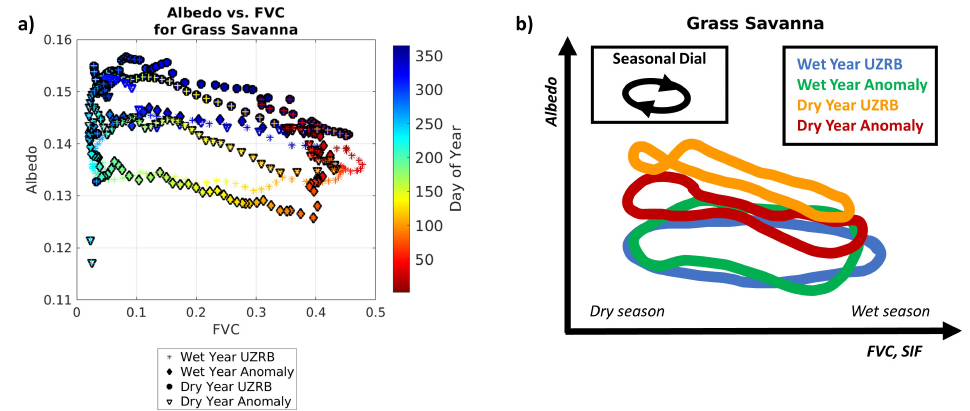
Figure 18. ( a ) Phase-space analysis of mean albedo and FVC values for grass savanna pixels for a wet year (2010–2011) and a dry year (2015–2016) across the entire UZRB, as well as for the midland wetland area that receives localized precipitation (Anomaly) [52]. The 95% confidence interval values were plotted as horizontal and vertical error bars, with bar lengths representing the distance of the interval endpoints to the mean. ( b ) On the right is a conceptual diagram that synthesizes the impact of afternoon convection (Anomaly) produced by local circulations organized by land–atmosphere interactions and groundwater convergence [52] on the seasonal cycle of albedo. This shows the importance of landscape organization of water fluxes in producing hot-spots of enhanced ecosystem